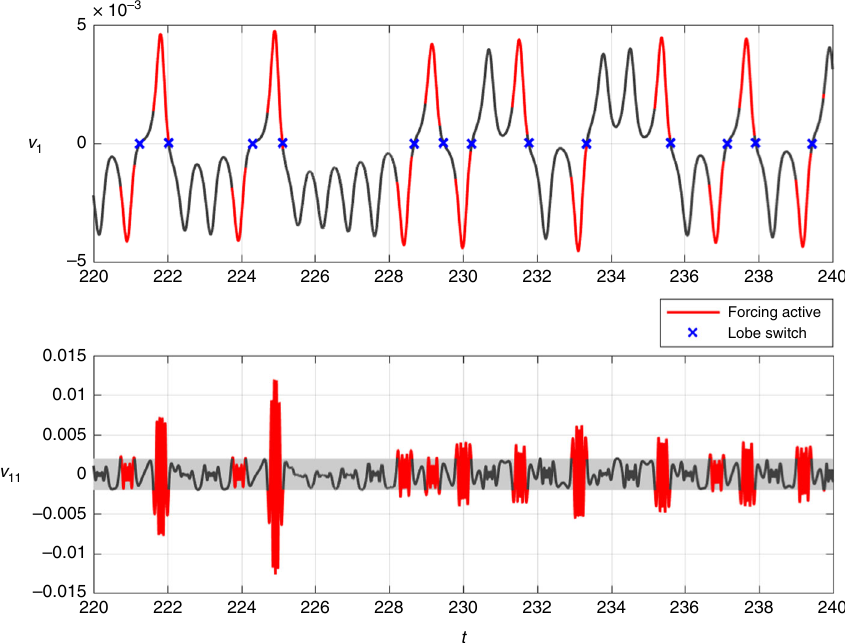
Fig. 3 Eigen-time-delay coordinate v 1 of the Lorenz system, colored by the activity of the forcing v r , for r = 11. When the forcing is active ( red ), the trajectory is about to switch, and when the forcing is inactive ( gray ), the solution is governed by predominantly linear dynamics corresponding to orbits around one attractor lobe. The forcing is active when v r j j > 0 : 002; this threshold was chosen by trial and error, although it could be varied to sweep out a receiver operating characteristic (ROC) curve to determine the optimal value based on desired sensitivity and speci fi